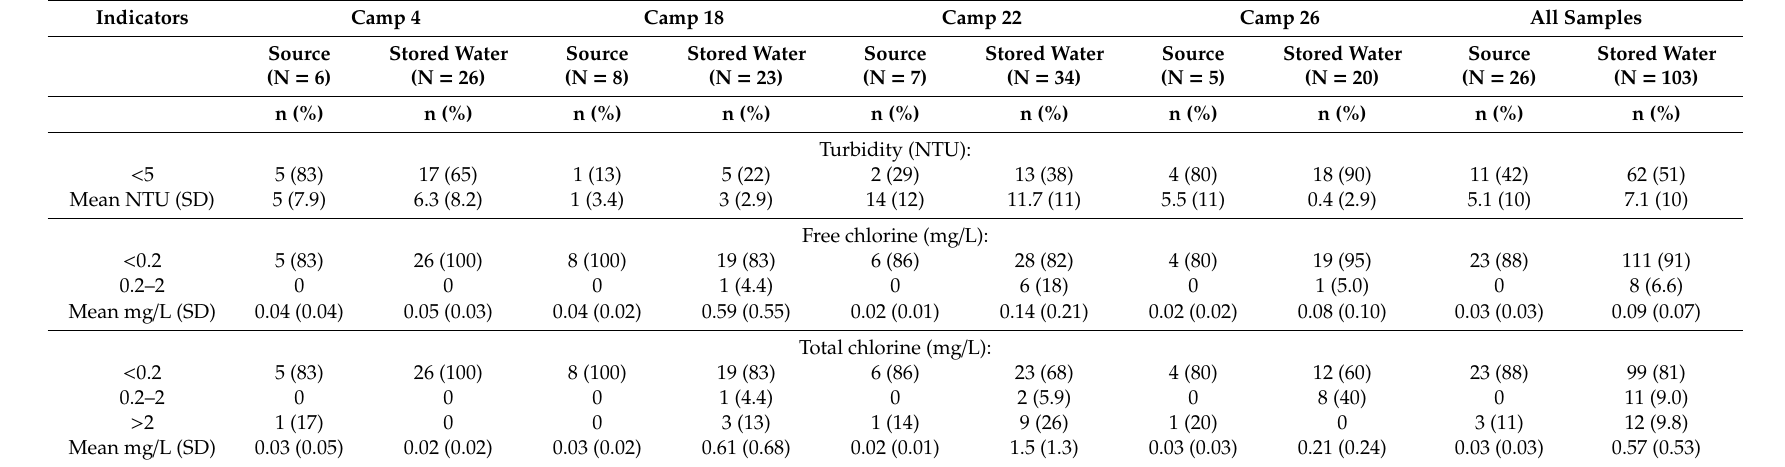
Table 4. Water residual chlorine and turbidity among Rohingya refugee camps in Cox’s Bazar, Bangladesh,